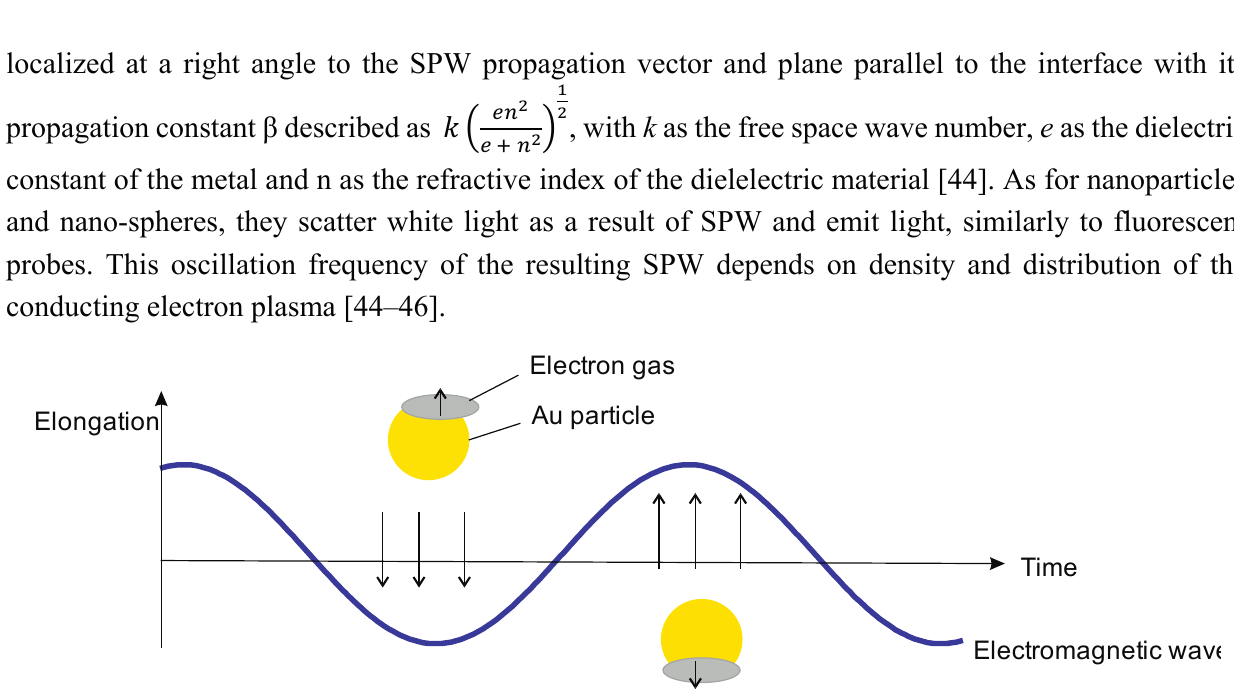
Figure 8. Surface plasmon waves can be regarded as oscillations of the electron gas of a noble metal nanoparticle in response to irradiation with polychromatic light. As shown here, the electron gas of a gold particle of the size below the wavelength of the irradiating light responds to the dislocation in response to the electromagnetic wave with an oscillation (see text for